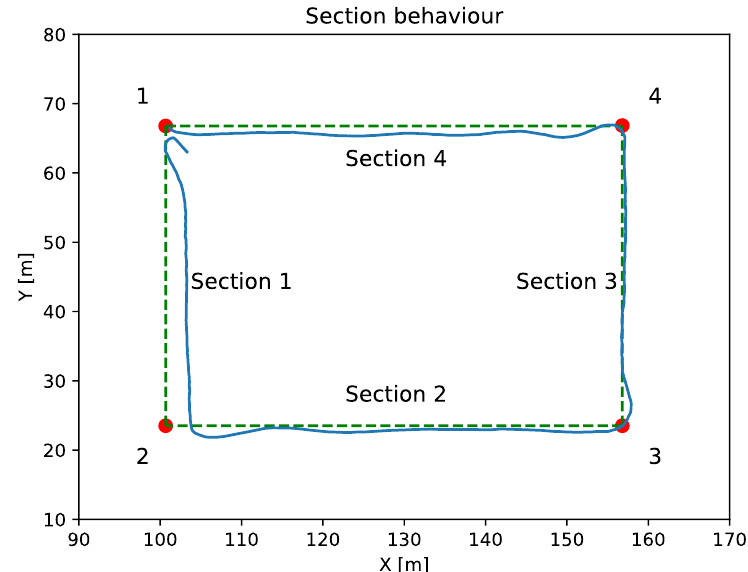
Figure 9. The green dashed line represents the programmed sections comprised between the waypoints represented as red dots. The blue line represents the vehicle route.